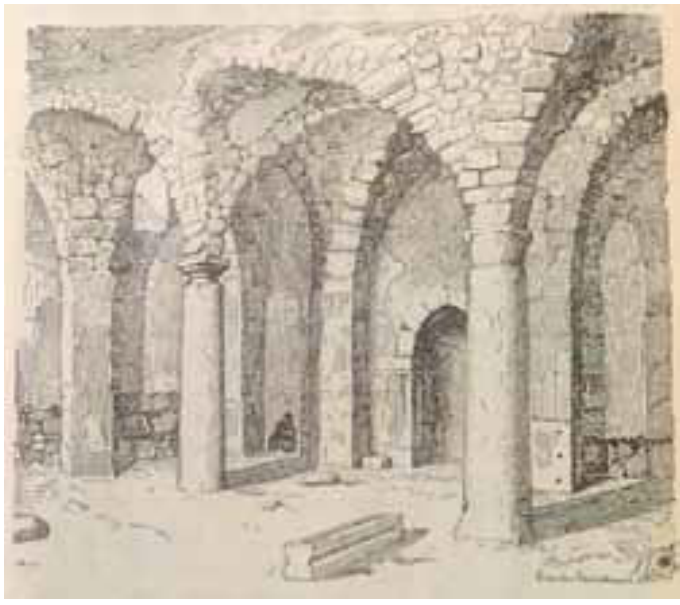
Figure 5. Inside Jami ʿ al-Yatim, from Kjaer 1931, p. 78.